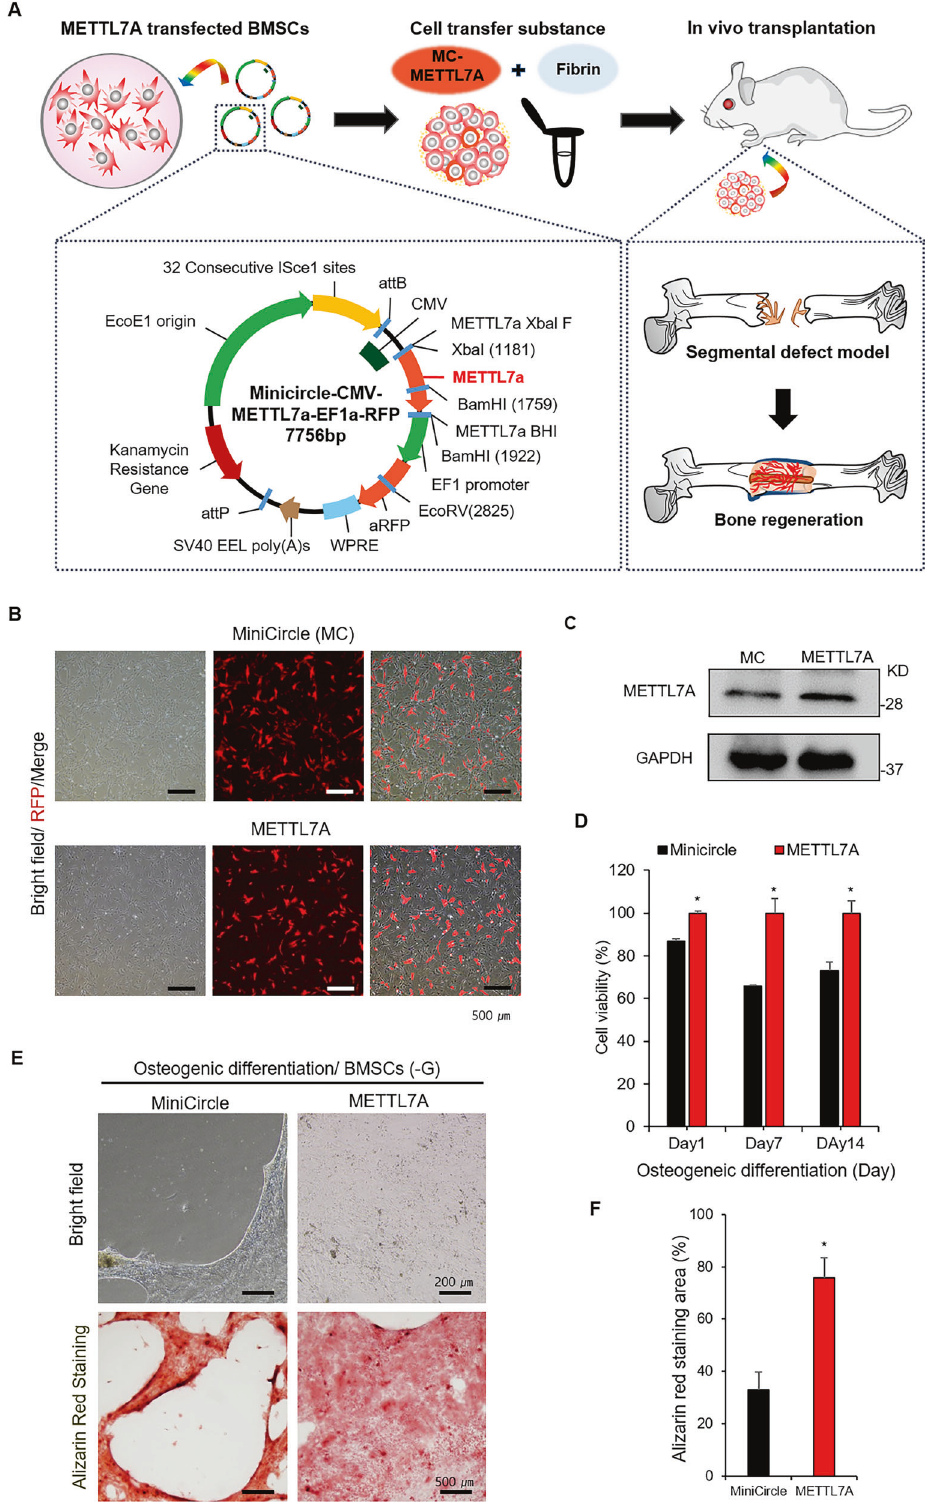
Fig. 4 Cell viability and osteogenic differentiation of METTL7A gene-transfected hBMSCs. A Construction of METTL7A minicircle plasmid vector. Vector also contains RFP fl uorescent genes. B Fluorescent, bright- fi eld and merge images of minicircle control vector (MiniCircle)- or METTL7A-transfected hBMSCs (METTL7A; RFP-tagged). C Western blots of METTL7A in hBMSCs. D Cell viability of hBMSCs cultured in glucose- free osteogenic medium on days 7, 14, and 21. E Alizarin Red staining images and F quanti fi cation of hBMSCs cultured in glucose-free osteogenic medium after 7 days of culture. Data were presented as mean ± standard deviation (SD, N = 3). NS: no signi fi cant difference, * p < 0.05, ** p < 0.01. hBMSCs: untransfected hBMSCs control; MC: minicircle plasmid vector (pMC)-transfected hBMSCs control; METTL7A: hMETTL7A- transfected hBMSCs.